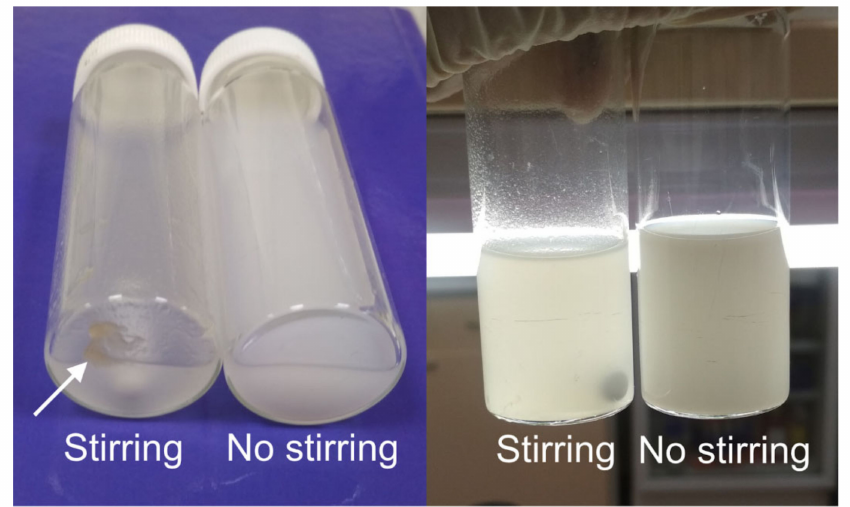
Figure 2. Gelatin nanoparticles prepared from gelatin B, 75 bloom by one-time addition of ethanol without stirring and by dropwise addition of ethanol under stirring. Large gelatin aggregates are labeled with